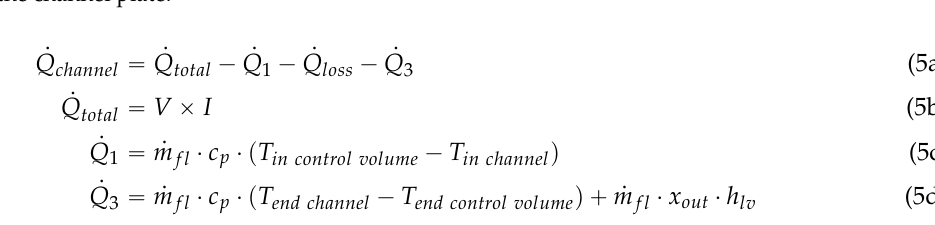
Figure 5. Schematic of the single microchannel evaporator. ( a ) isometric view of channel plate. ( b ) cross section of the channel